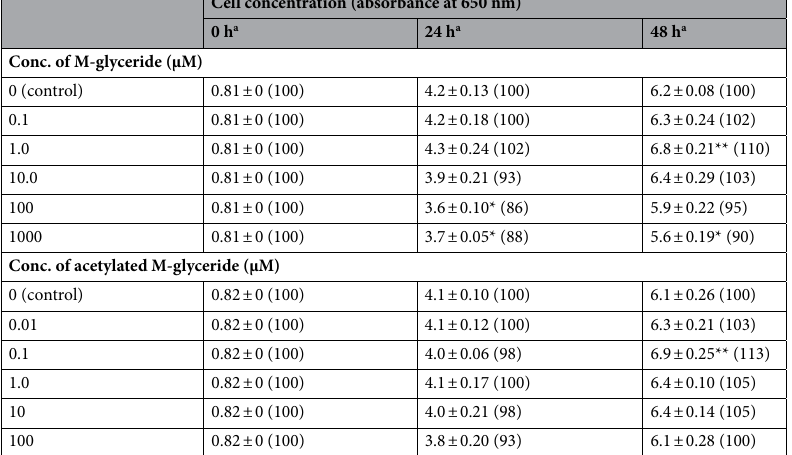
Table 6. Effect of M-glyceride and acetyl M-glyceride on cell growth of Aurantiochytrium sp. SYLR6#3. Cells of A . sp. were cultured with M-glyceride or acetylated M-glyceride containing a growth medium using 16 well plates at 25 °C for 24 or 48 h. Cell concentrations were determined using a photoelectric colorimeter at 650 nm, and were expressed as absorbance of cell suspension. Values are averages of independent experiments with ± SD (n = 4). M-glyceride: 1,2- didocosapeentaenylglyceryl-2 ′ -oxy-3 ′ -oxomorpholino propionic acid; Acetylated M-glyceride: 1.2 diacetylglyceryl-2 ′ -oxy-3 ′ -oxomorpholino propionic acid; M-glyceride and acetyl M-glyceride were included 14% of their hydrate type. Differences of cell concentrations after inoculation between control and the M-glyceride or acetylated M-glyceride containing media were tested statistically significant by Student’s t test. a Time (h) after inoculation. **Cell growth stimulation p < 0.005; *cell growth inhibition p <